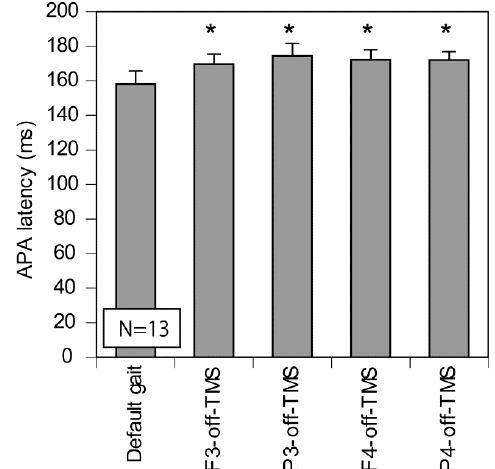
Figure 4. The APA latency of the tested gait initiation in the o ff -TMS condition and that of the default gait initiation. In the default gait initiation, the participants initiated the gait from an even feet position, but in the o ff -TMS conditions, they initiated the gait from the tested feet position in which the probability of the initial swing leg was about equal between the left and right. The bars indicate the mean and the error bars indicate the standard errors of the mean. Asterisks indicate that the APA latency in the tested gait initiation was significantly longer than that in the default gait initiation (multiple comparison test; p <